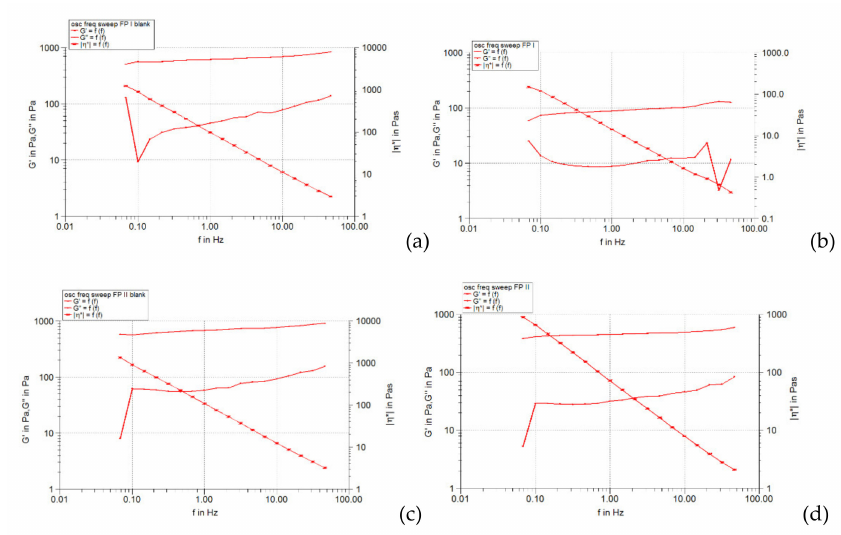
Figure 5. Behavior of G’ and G” viscoelastic modules depending on frequency for Carbopol 940 and propylene glycol hydrogels, simple or loaded with caffeic acid liposomes: ( a ) FPI blank, ( b ) FPI, ( c ) FPII blank, ( d ) FPII.